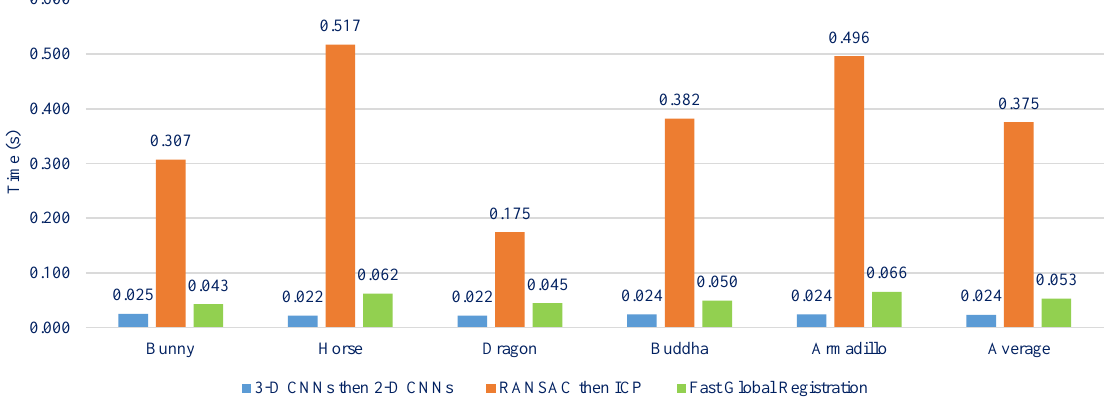
Figure 11. The comparison about average computation time of 20 tested samples.